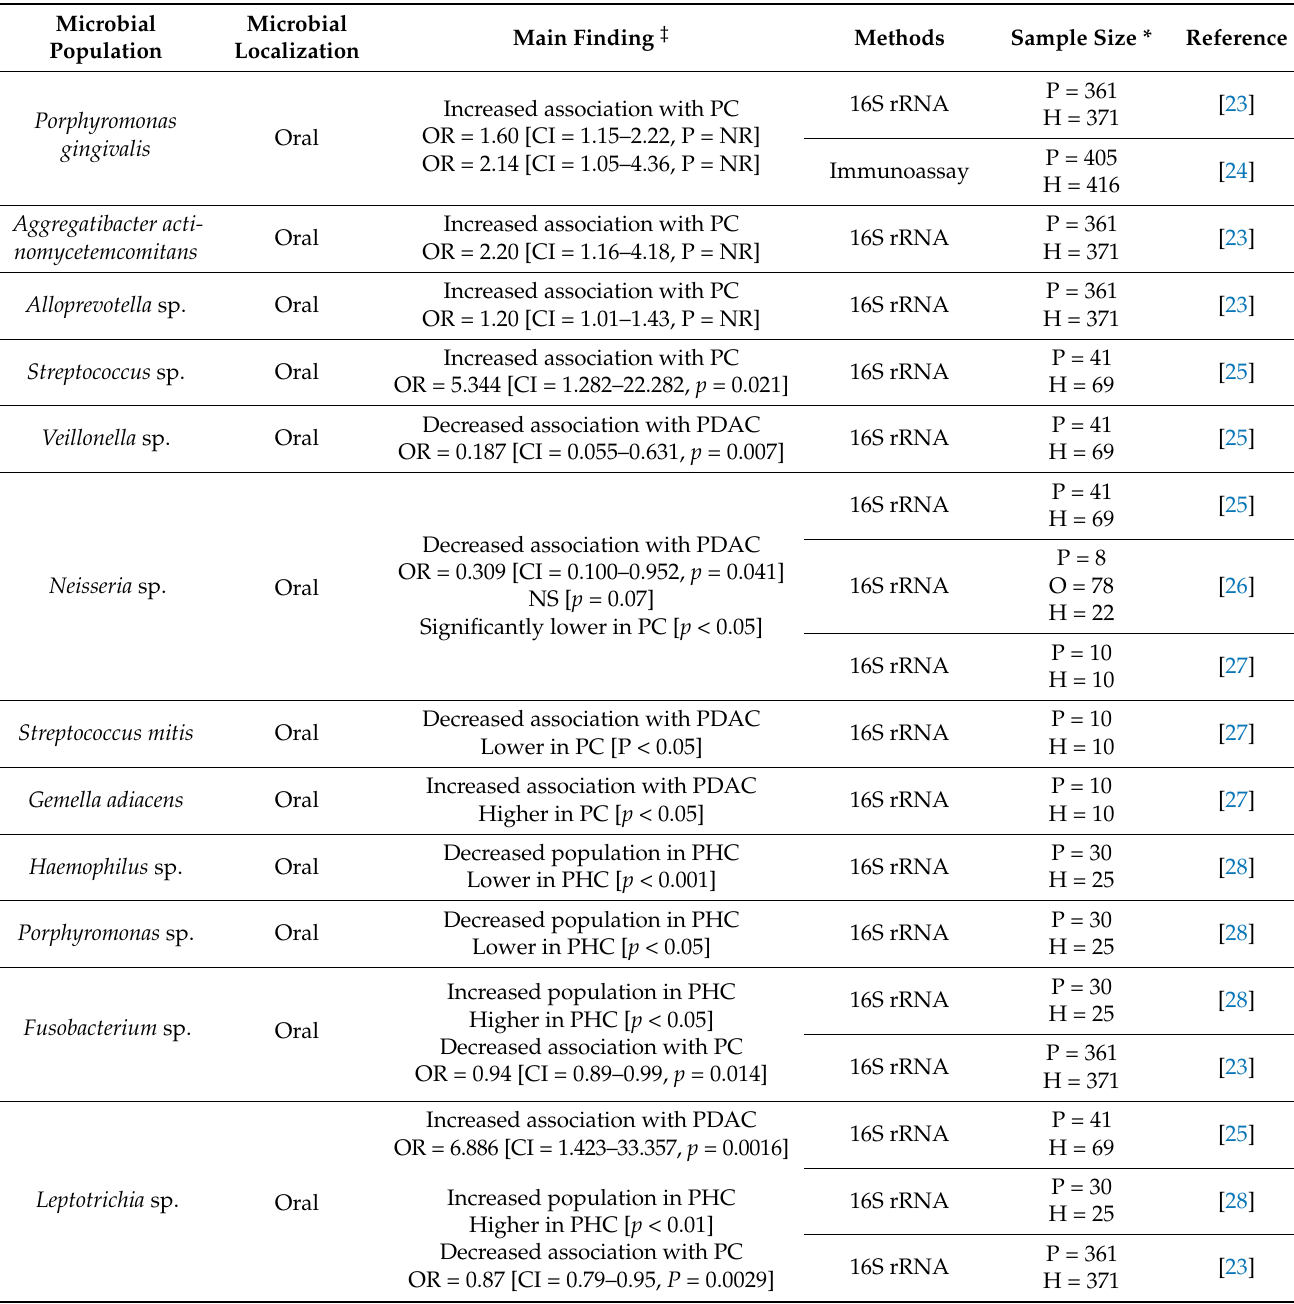
Table 1. Microbial associations with pancreatic